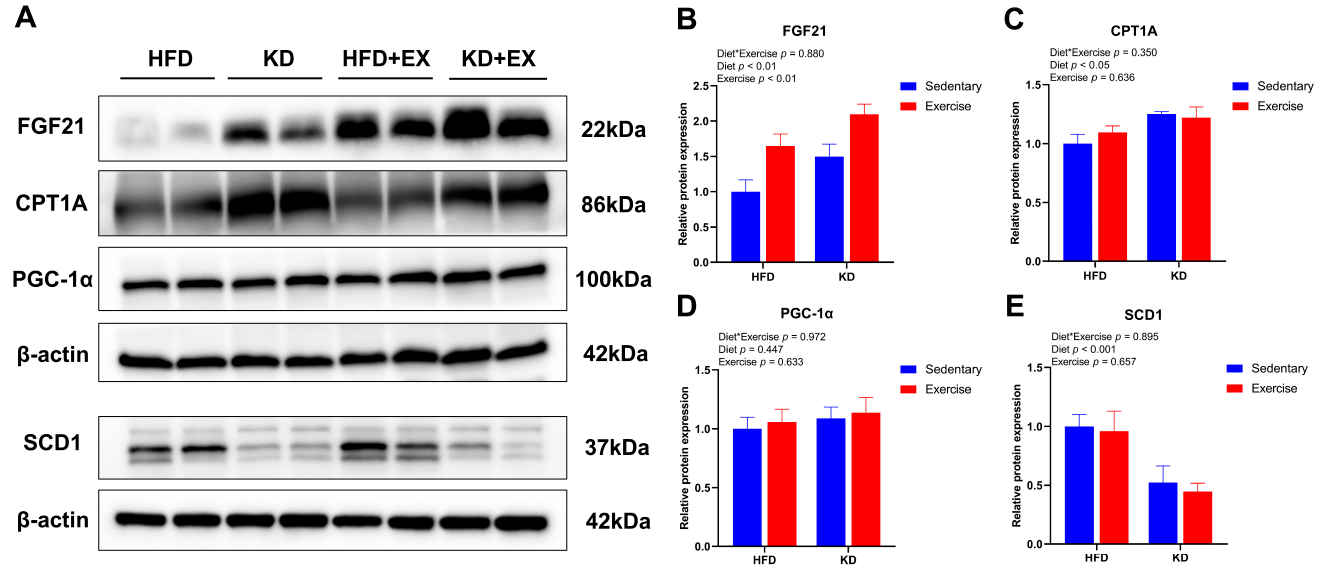
Figure 7. Effects of KD intervention and KD combined with exercise on the fatty acid oxidation and synthesis-related protein expression in each group of mouse livers. ( A ) Representative western blots. Protein quantification analysis of ( B ) FGF21, ( C ) CPT1A, ( D ) PGC-1 α and ( E ) SCD1 in livers. Data are presented as mean ± SEM, n = 6. For panels B–E, p values from the two-way ANOVA (i.e., main diet and exercise effects and diet*exercise interactions) are presented in the top left corner.